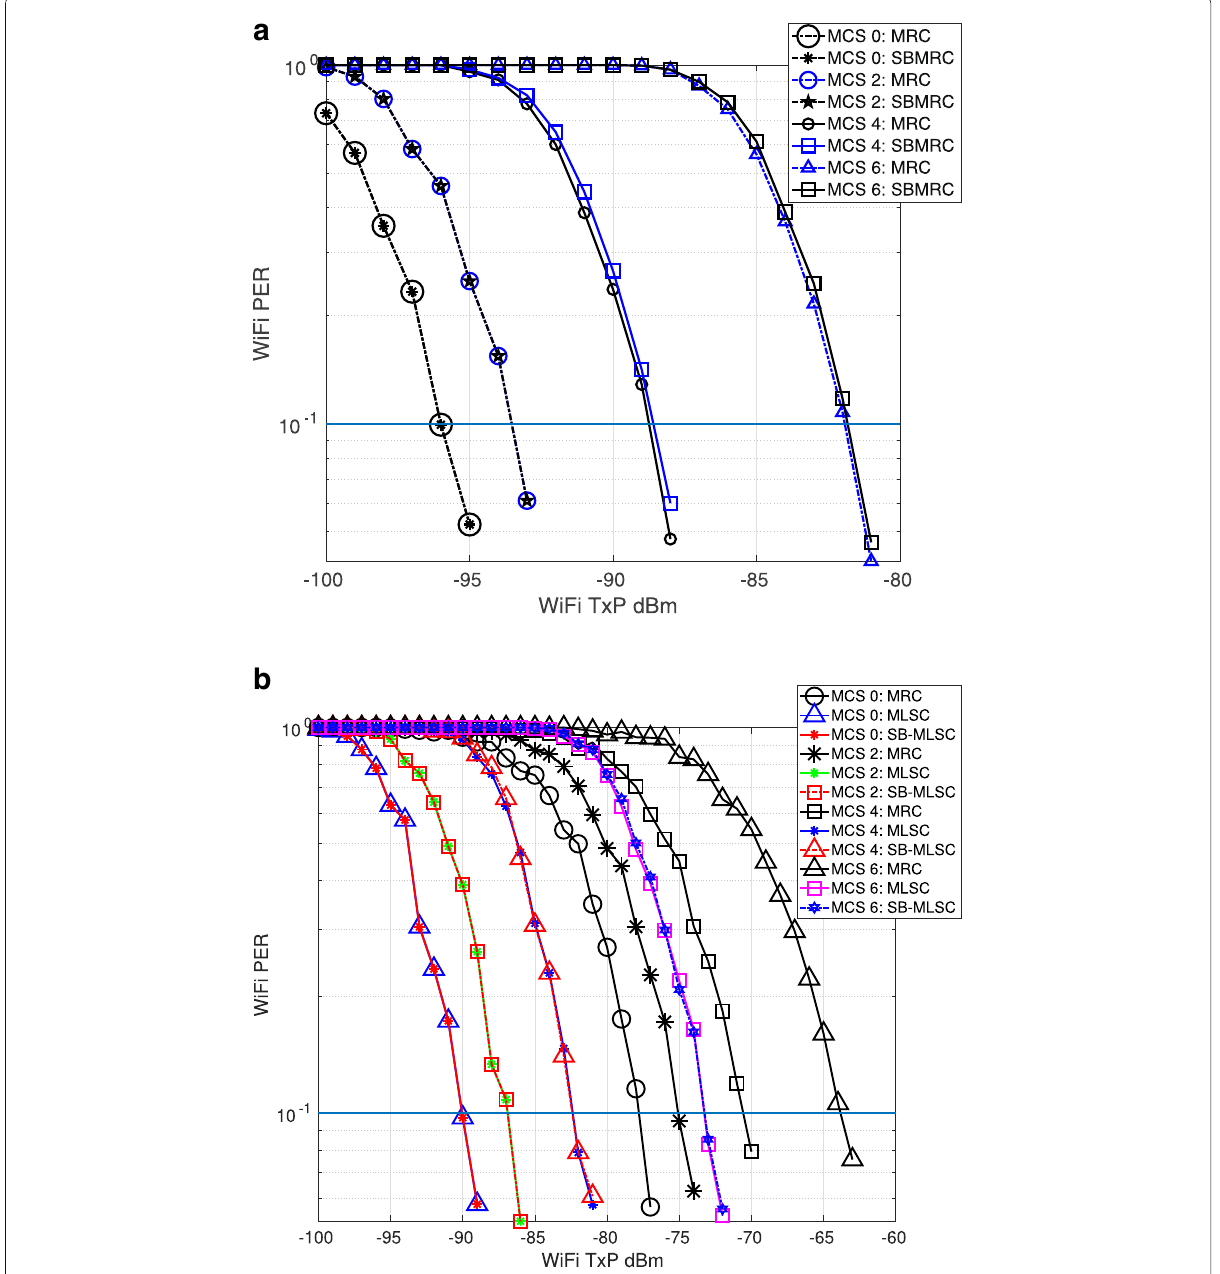
Fig. 15 a MRC vs SBMRC in the absence of interference. Both of them perform the same in the absence of interference under the same channel conditions. b Performance comparison of MRC, MLSC, and SB-MLSC in the presence of a single interferer. SB-MLSC and MLSC show similar performance and both of them outperform conventional MRC by a significant SNR